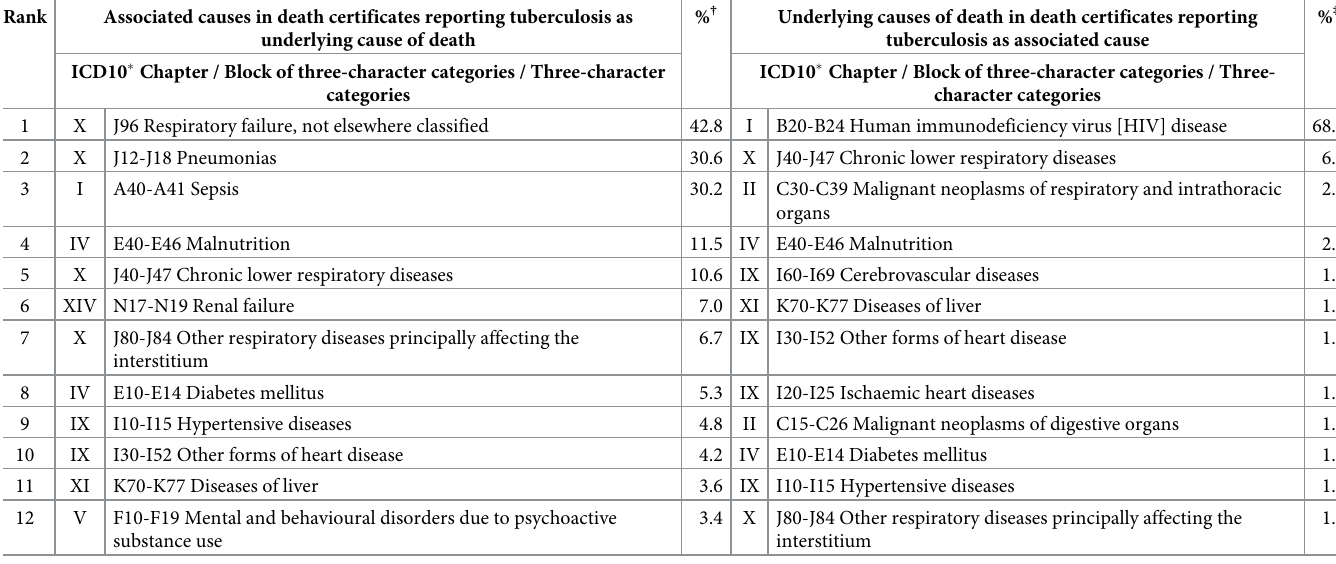
Table 2. Distribution of associated causes on death certificates which reported tuberculosis as the underlying cause of death, and underlying causes on death certifi- cates which reported tuberculosis as an associated cause of death, Amazonas State, Brazil, 2006 to 2014 § . Rank Associated causes in death certificates reporting tuberculosis as % † Underlying causes of death in death certificates reporting % ‡ underlying cause of death tuberculosis as associated cause ICD10 � Chapter / Block of three-character categories / Three-character ICD10 � Chapter / Block of three-character categories / Three- categories character